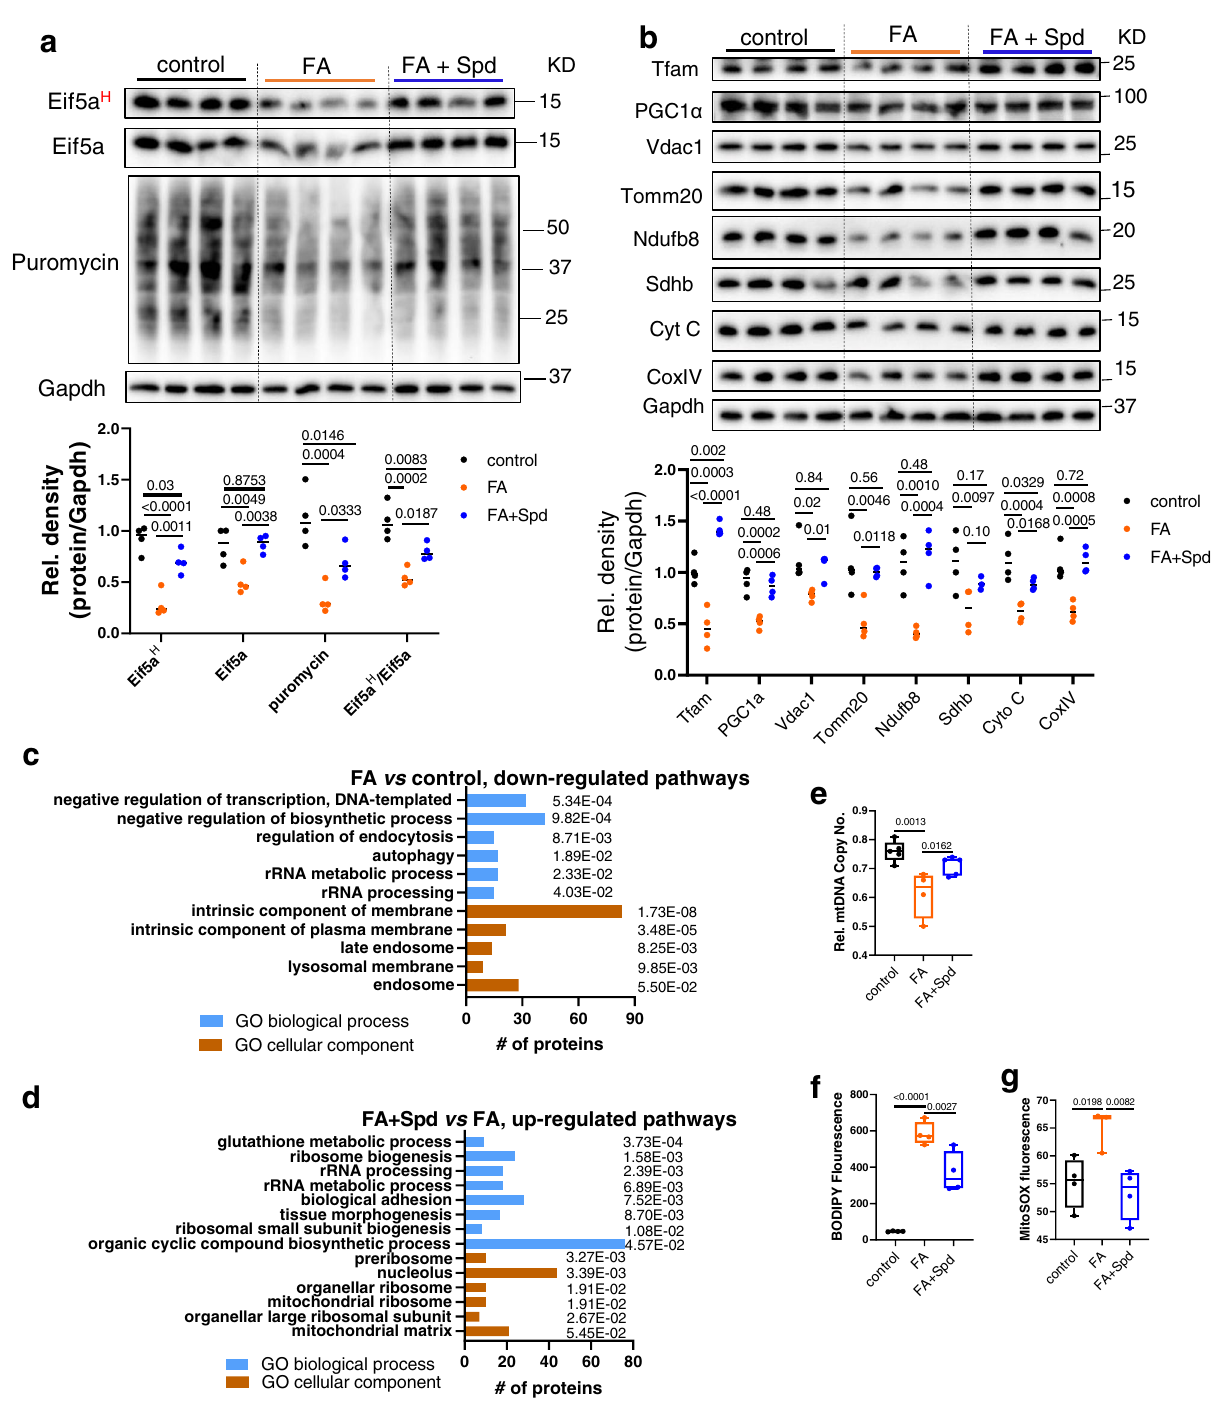
Fig.3|FAdecreasedEif5a H ,proteinsynthesisrateandmitochondrialproteins, which can be rescued by co-treatment with spermidine. a , b Western blot and densitometric analysis of Eif5a H and total proteins after puromycin incorporation ( a ), and mitochondrial proteins ( b ) in control, FA − , and FA+ Spd-treated AML12 cells. ( n =4). c , d Proteomics and gene ontology (GO) enrichment analysis (with corrected p value indicatedon the bar) ofdownregulated proteins in FA-treated vs control AML12 cells( c ),and upregulatedproteins in FA+Spd-treated vs FA-treated AML12cells( d ).ABonferronicorrectionwasappliedtocorrectformultipletesting. e – g Relative mitochondrial copy number (( e , control ( n =5), FA ( n =4), FA+Spd